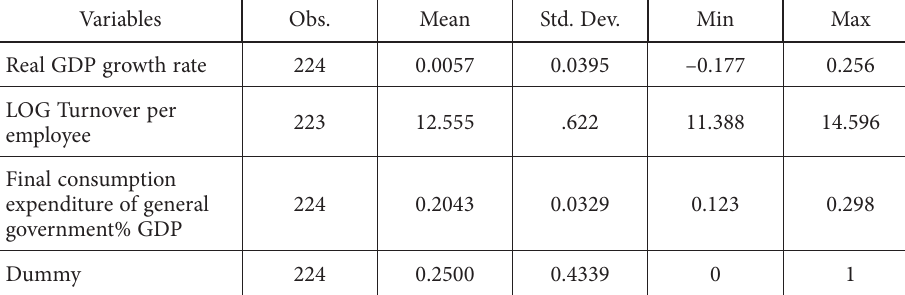
Table 1. Descriptive statistics and names of variables (source: authors’